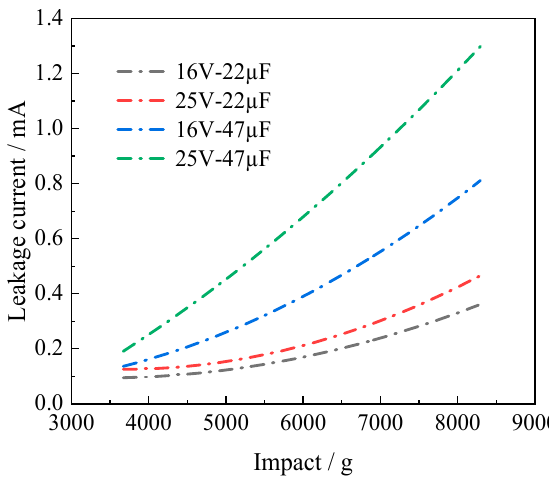
Figure 16. Relationship between leakage current and impact acceleration of the MLCC.